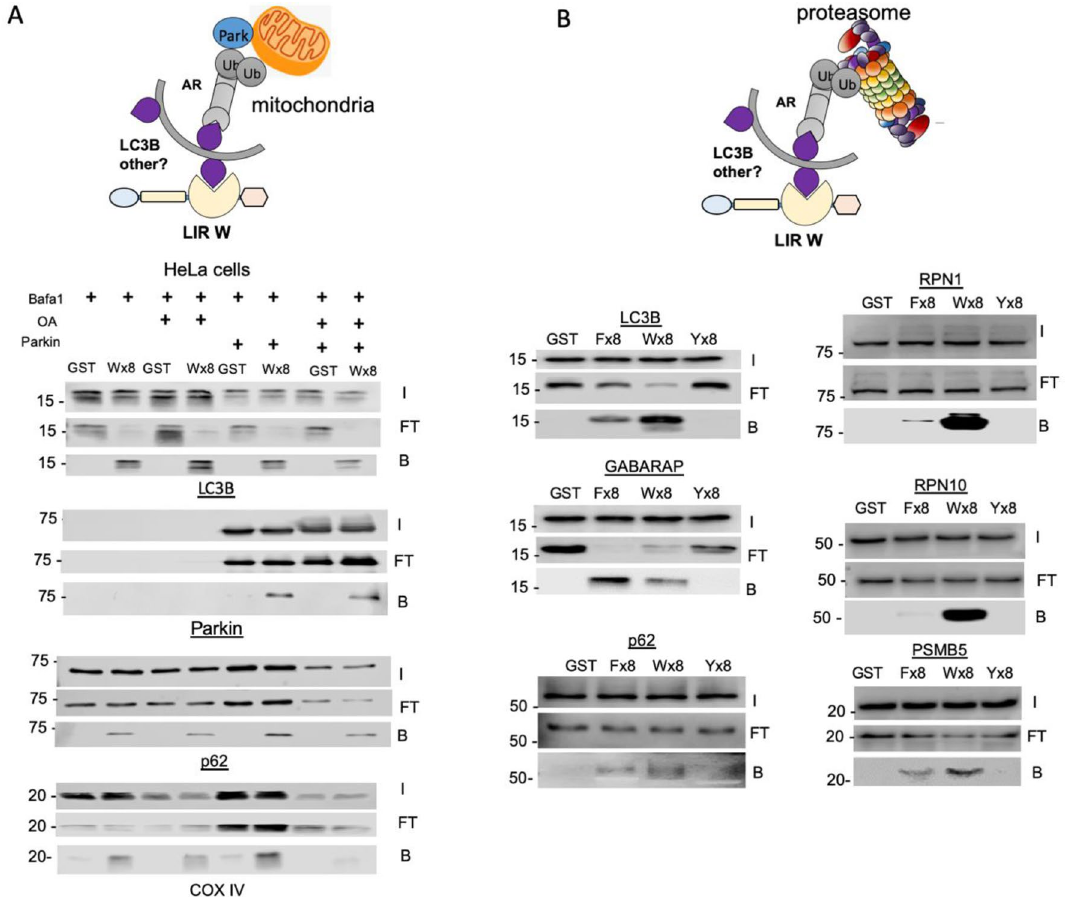
Figure 5. LC3 traps isolate substrates degraded by distinct selective autophagy pathways. ( A ) Analysis of parking induced mitophagy in HeLa cells transfect or not with parking and treated with Bafilomycin A (Bafa 200 nM) or Bafa + Oligomycin/Antimycin (200 nM + 10 µM each). One milligram of total protein from these lysates were incubated 4 h with 100 µg of either GST control or Wx8 traps. Input (I), flow-through (FT) or bound (B) fractions were analysed with specific antibodies for the indicated proteins including mitochondria membranes protein COX IV and mitochondria associated protein Parkin. ( B ) Analysis of the permanently activated proteaphagy present in ZBR cells. Capture of proteasomes subunits was performed using Fx8, Wx8 or Yx8 LC3 traps. 500 µg of total protein lysates from ZBR cells treated with BafA were incubated 4 h with each LC3-trap. Input (I), flow through (FT) and bound (B) fraction were analysed by Western blot with the indicated specific antibodies. PVDF membranes were cut before antibody incubation to blot for several co-treatment with Bafilomycin A (BafA) was used to block lysosomal degradation. In mammalian cells various autophagy receptors have been implicated in mitophagy including Optn, NDP52 and p62 10,28,29 . Deletion of a single receptor appears to be partially compensated by another, highlighting their functional redundancy 30 . Since p62 contains a W-LIR motif, we used the W LIR-trap 12 . Total cell extracts were incubated with puri- fied LC3 traps with Wx8 LIR motifs. Input, Flow through and bound fraction were analyzed by Western blot (Fig. 5A). Our results indicate that LC3B is efficiently captured in all conditions tested. Both autophagy receptor p62 and the mitochondrial protein COX IV were bound to Wx8 LC3-trap (Fig. 5A). Following OA induction, degradation of both proteins by the autophagy process, observed in Input conditions, results in reduced binding by LC3-Traps. Interestingly, Parkin is also efficiently captured by Wx8 LC3-trap when expressed, indicating that during the ubiquitin-dependent mitophagy, not only LC3-binding but also cargoes-associated proteins could be captured by LC3-traps. Results obtained in yeast and HeLa cells therefore indicate that LC3-traps can be used to explore mitophagy in various biological models.